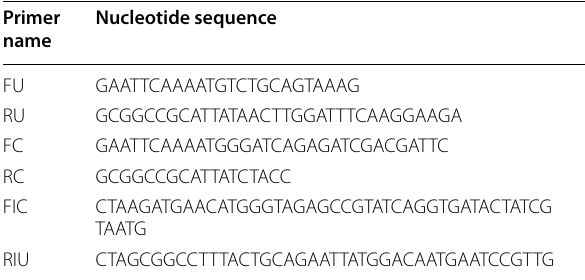
Table 1 List of primer sequences used in this